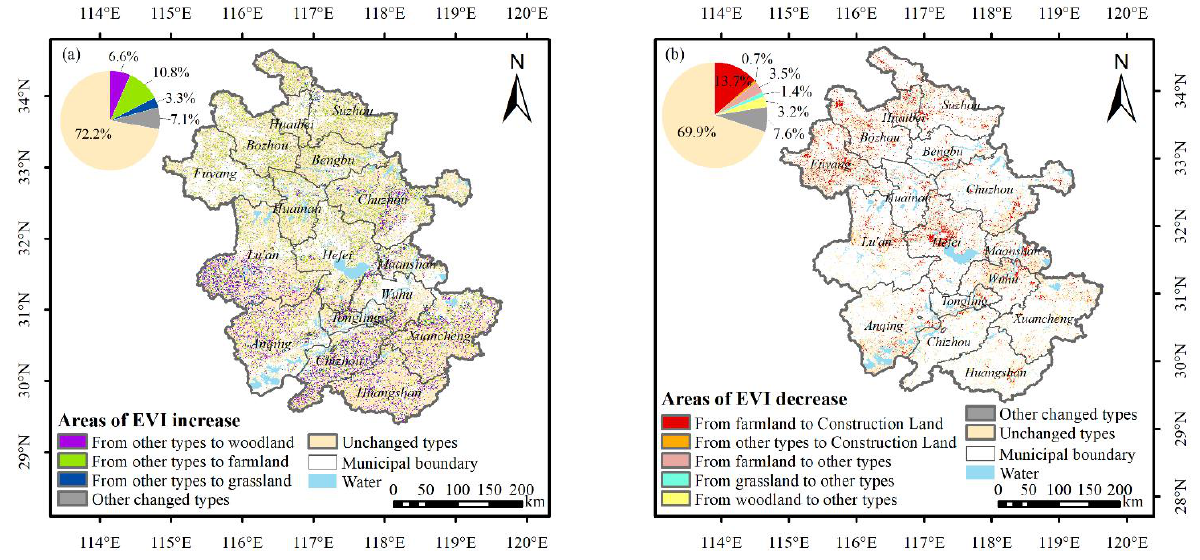
Figure 9. Superposition analysis of land-use change and Slope of EVI variation in Anhui Province. ( a ) Areas of EVI increase and ( b ) decrease. EVI changes of different land use types transferred was quantified at the pixel-scale